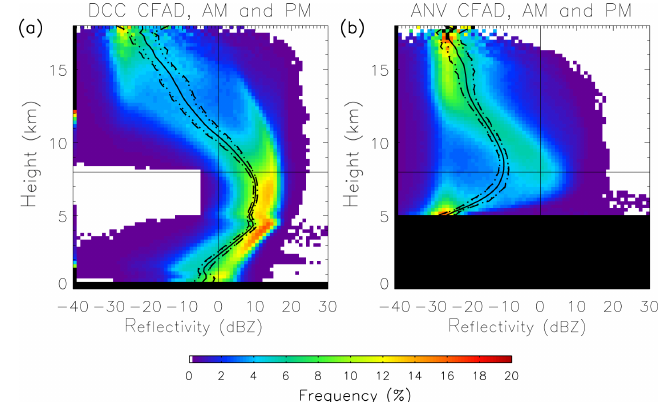
Figure 4. (a) The CFAD for DCCs, same as Fig. 3. The black curves near the center of the data are the average reflectivity profiles. Dashed lines are the standard deviation bounds. (b) Same as (a) , but for